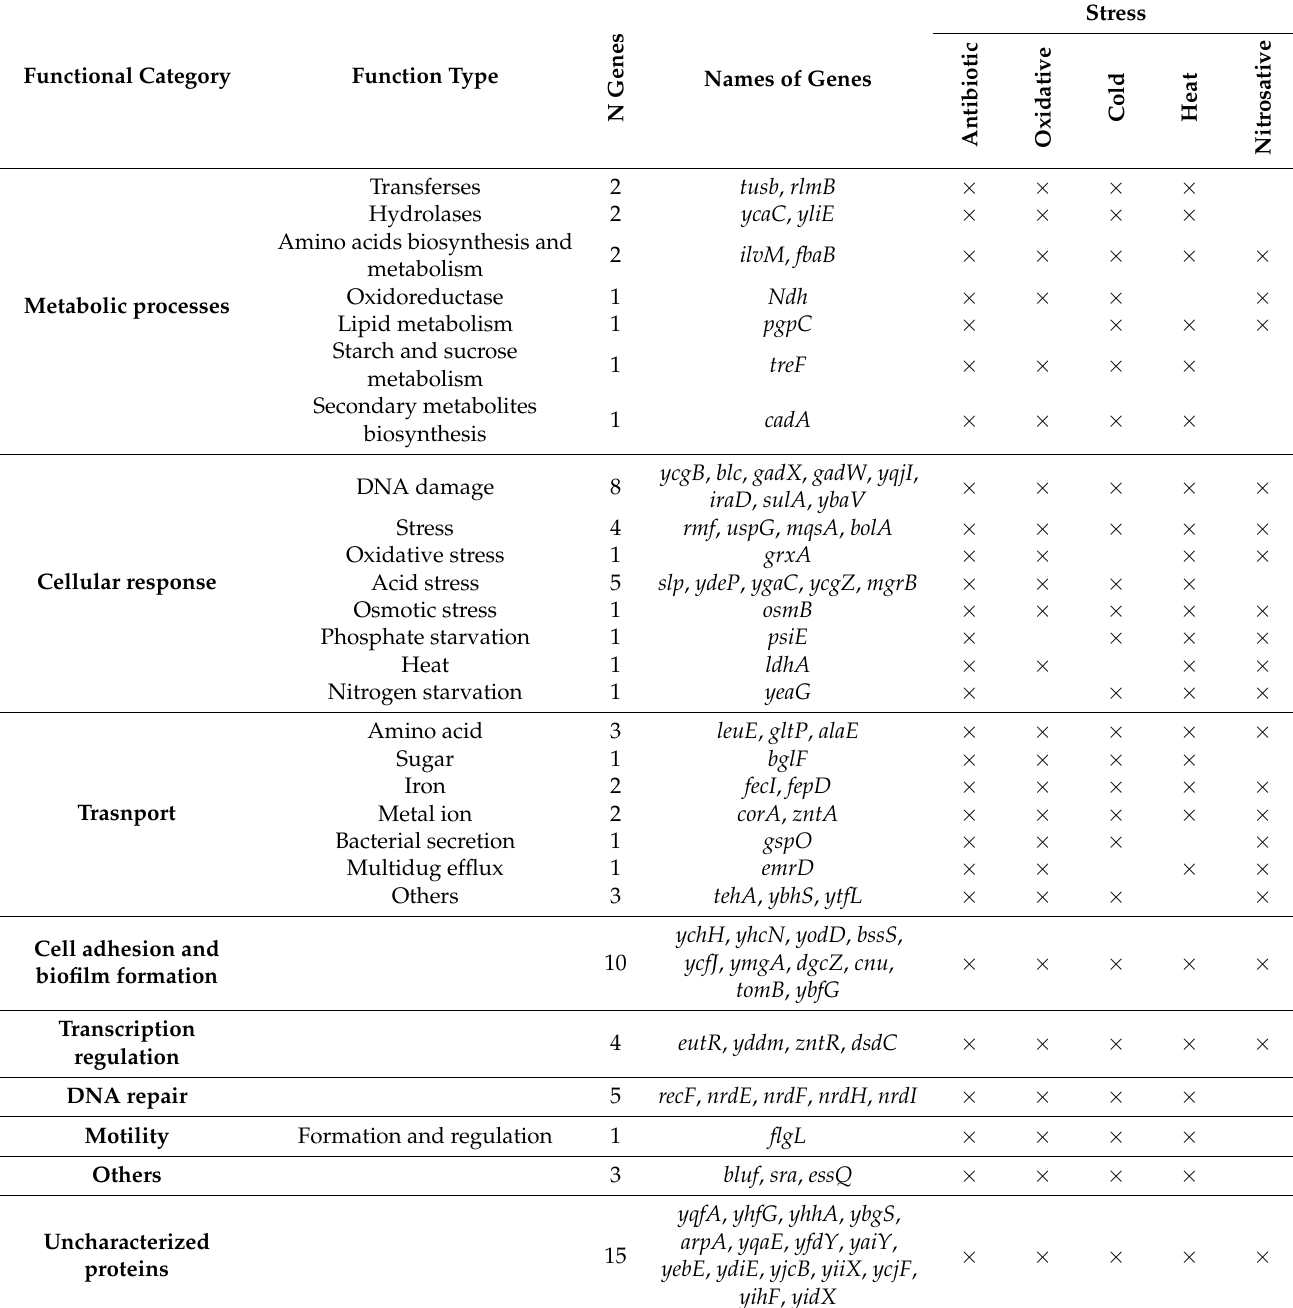
Table 2. Upregulated gene functions in multiple conditions (at least four